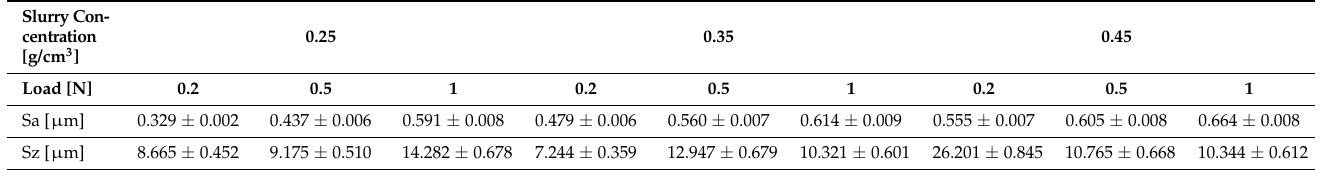
Table 4. Results obtained from the amplitude parameters (Sa and Sz) in the height deviation of the topography of the balls. Surface texture ISO 25178; Height parameters ( µ